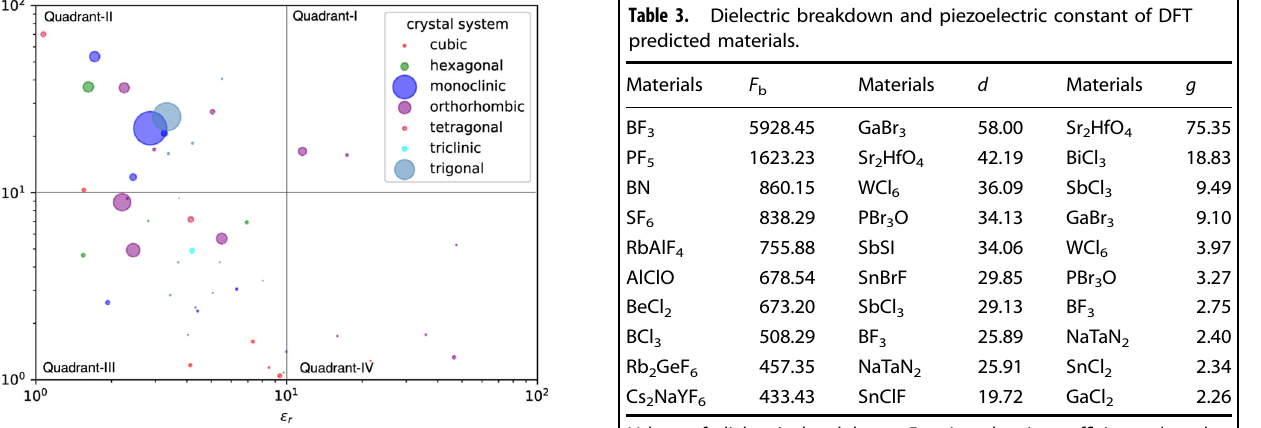
Values of dielectric breakdown, F b , piezoelectric coef fi cients d , and g Fig. 5 Plot of permittivity versus compressibility obtained from computed from calculated from Eqs. (8), Equation (9), and Eq. (10), DFT calculations. Electrostrictive coef fi cient Q DFT as in Eq. (3) falls respectively. The unit of F b , d , and g are MVm – 1 , 10 − 12 mV − 1 and, V mN – 1 , h values appearing is along the quadrants I and III with larger Q DFT respectively. The data for top-ten materials are tabulated. All calculations h values in quadrant-I. quadrant-III and small Q DFT were carried out at 0 K and therefore on materials in their solid h